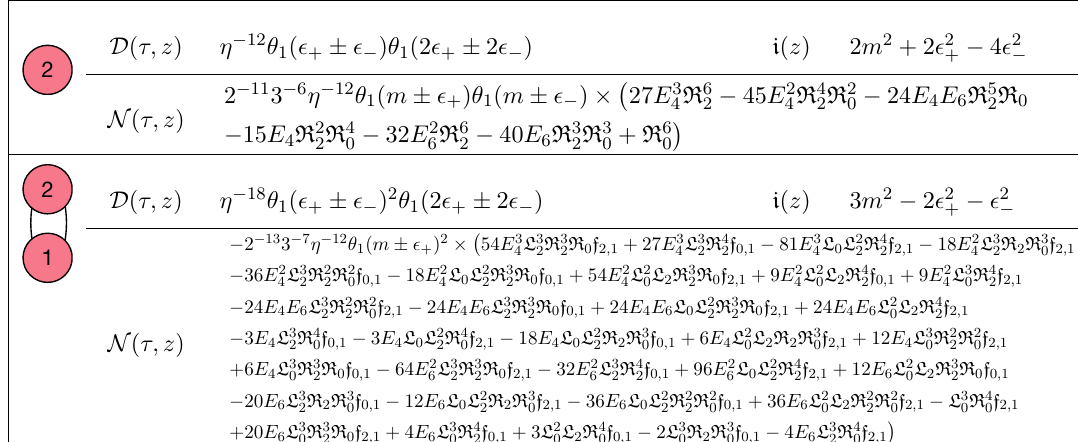
Table 2 . Elliptic genera of (2 ; 0) string chains determined from I 0